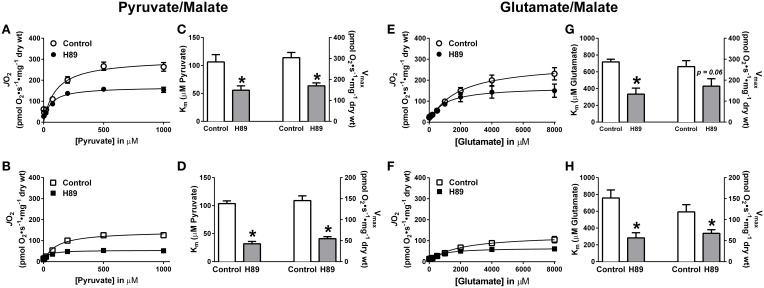
Effects of PKA inhibition on substrate oxidation kinetics in mouse PmFBs. Pyruvate titrations were performed in PmFBs from RG (A) and WG (B) in the absence (open symbol) or presence (closed symbol) of 10 μM H89 in the assay media. Km and Vmax were determined based on Michaelis-Menten like kinetics in RG (C) and WG (D). N = 4–8/condition. * denotes p < 0.05 compared to Control. Glutamate titrations were performed in RG (E) and WG (F) in the absence (open symbol) or presence (closed symbol) of 10 μM H89. Km and Vmax were determined based on Michaelis-Menten like kinetics in RG (G) and WG (H). N = 4–8/condition. * denotes p < 0.05 compared to Control.